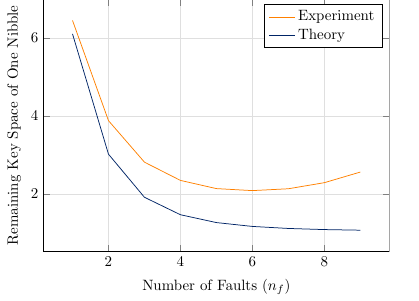
Figure 5: Single nibble remaining key search space of 16 chosen plaintexts (LED-64).